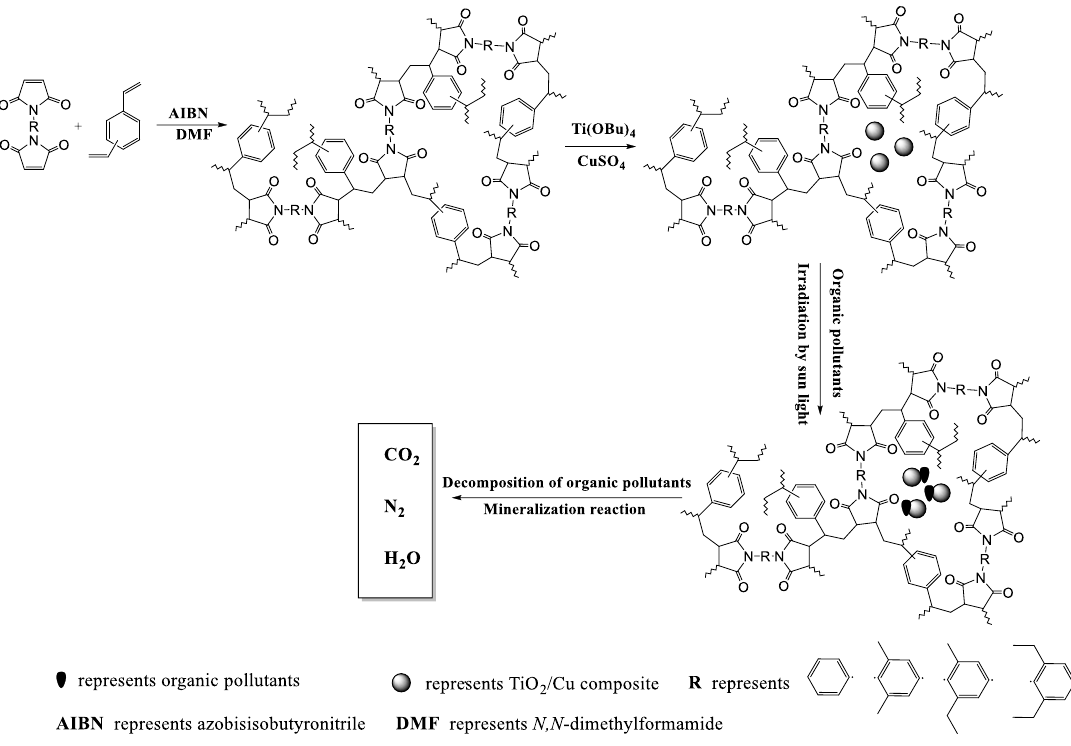
Figure 1. Schematic diagram for preparing ketch porous polymers and PPTC.